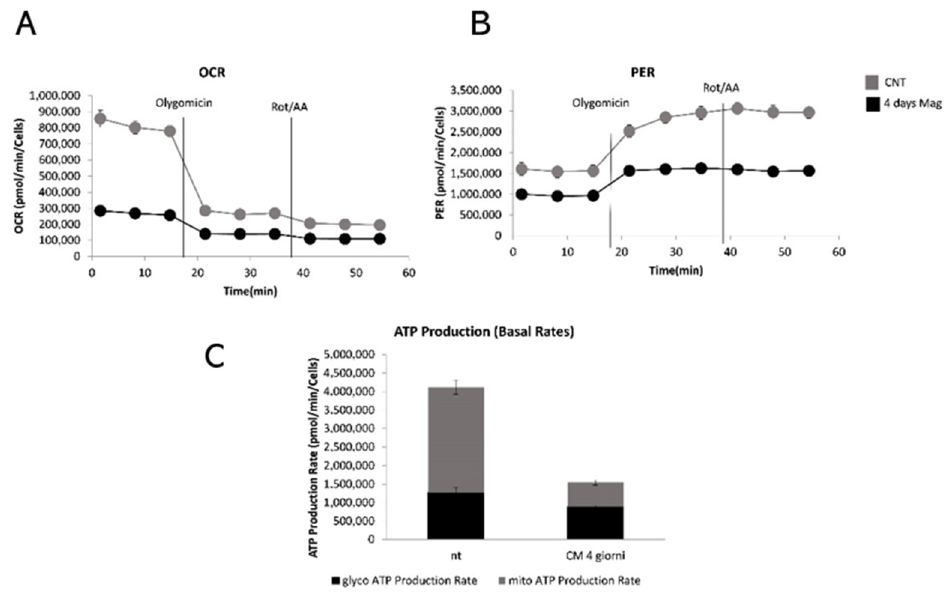
Figure 4. ATP rate assays. ( A ) Analysis of oxygen consumption. The rates of oxygen consumption (OCR) were measured with sequential additions of oligomycin (1.5 μ M), rotenone (3.0 μ M). ( B ) Proton efflux rate (PER). ( C ) ATP production rate.